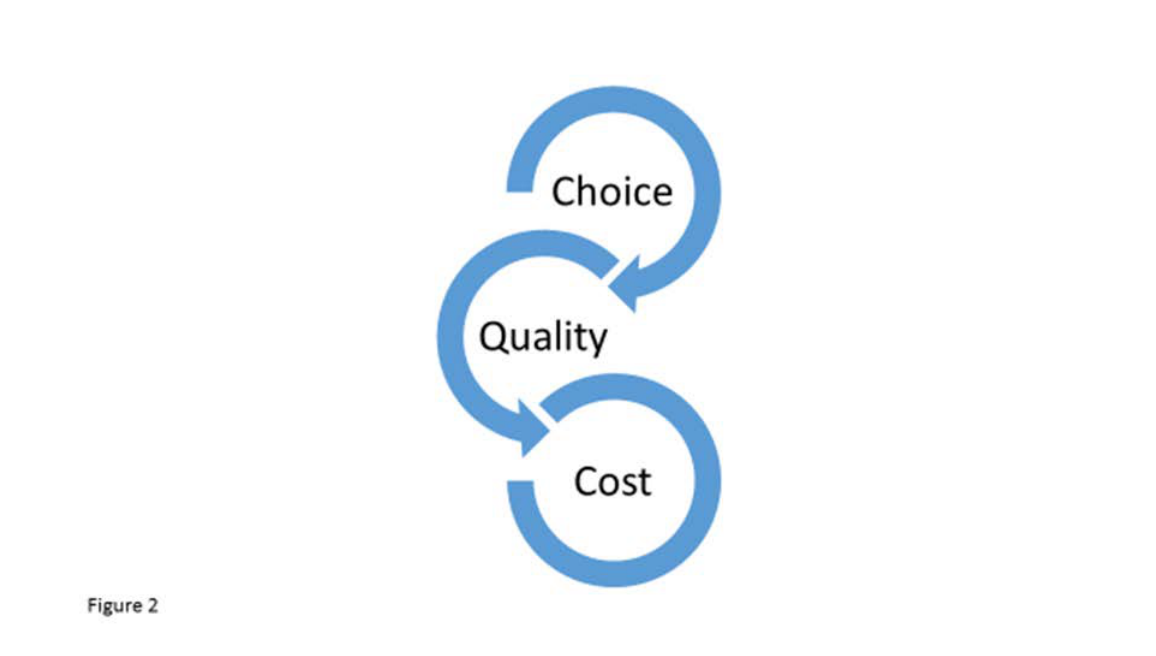
Figure 2: Health policy